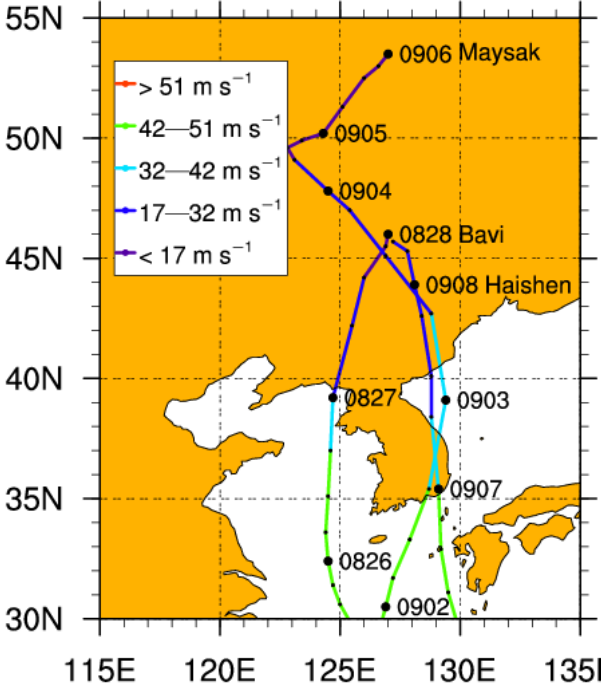
Figure 1. Three TCs that affected Northeast China in 2020. The numbers represent the dates; the large black dots represent 0000 UTC; the small black dots represent 6-hour intervals; the colors represent the central maximum wind speed. The data source is the Western North Pacific Tropical Cyclone Database produced by the China Meteorological Administration [31].